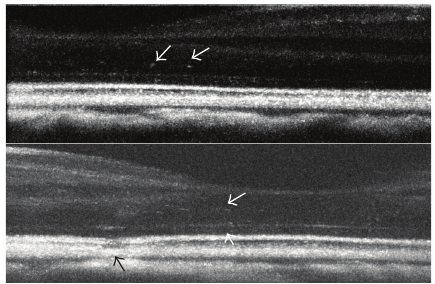
Figure 12: Projection view of OCT cross-sections of 413 nm exposures (24 hours) not visible in color fundus photos at the 1- hour or 24-hour time point. Retinal exposures ranged from 225 to 1,089 J/cm 2 . Lesions eventually became visible in color fundus photos 3 days later. Note the hyperreflective regions and threading present (white arrows). Black arrow denotes thermal marker lesion.